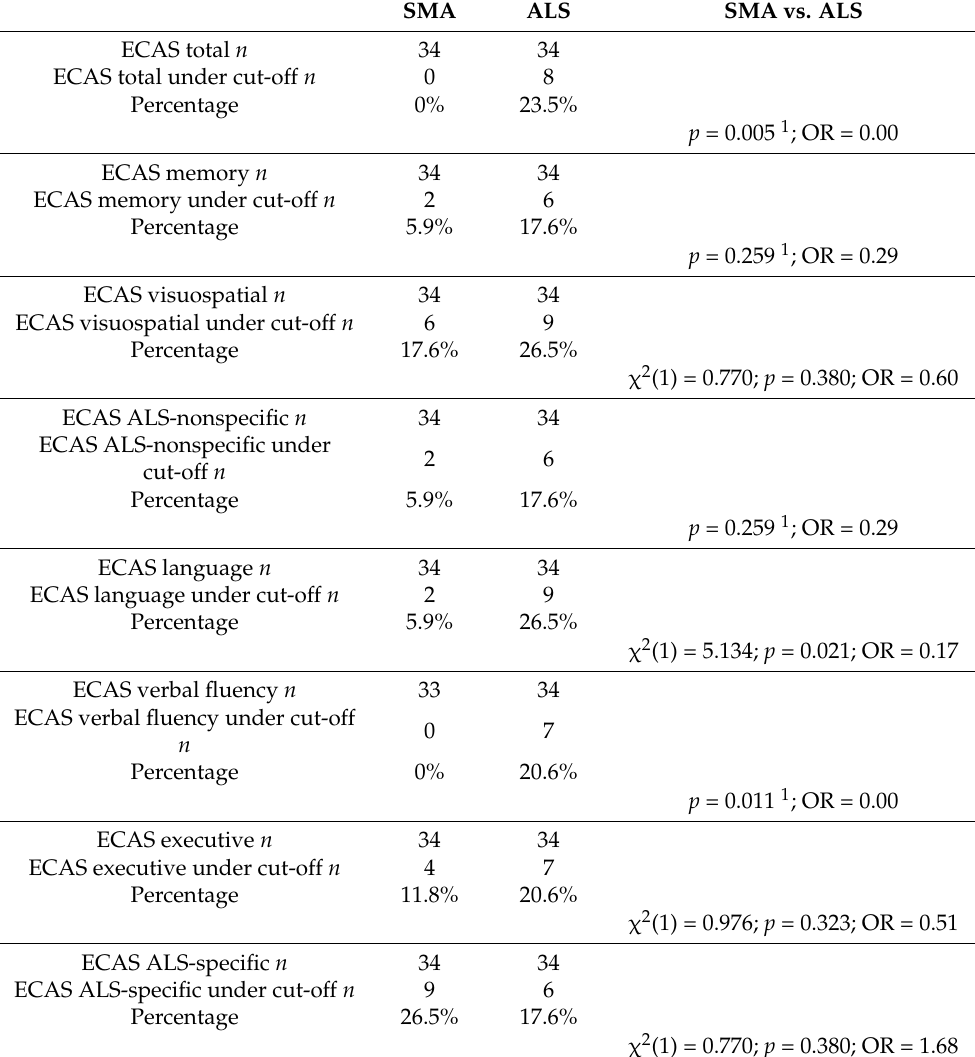
Table 2. Age- and education-adjusted ECAS cot-off scores. Number of SMA and ALS patients who reached ECAS under cut-off scores (with respect to the total score and ECAS subdomains). Abbre- viations: SMA, Spinal Muscular Atrophy; ALS, Amyotrophic Lateral Sclerosis; ECAS, Edinburgh Cognitive and Behavioural ALS Screen; n , number; vs., versus; OR, odds